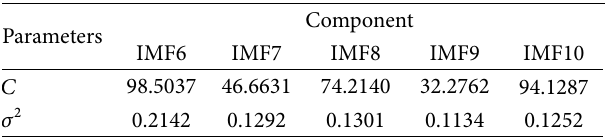
Table 10: The parameters of LS‐SVM model of each intermediate and low frequency component.